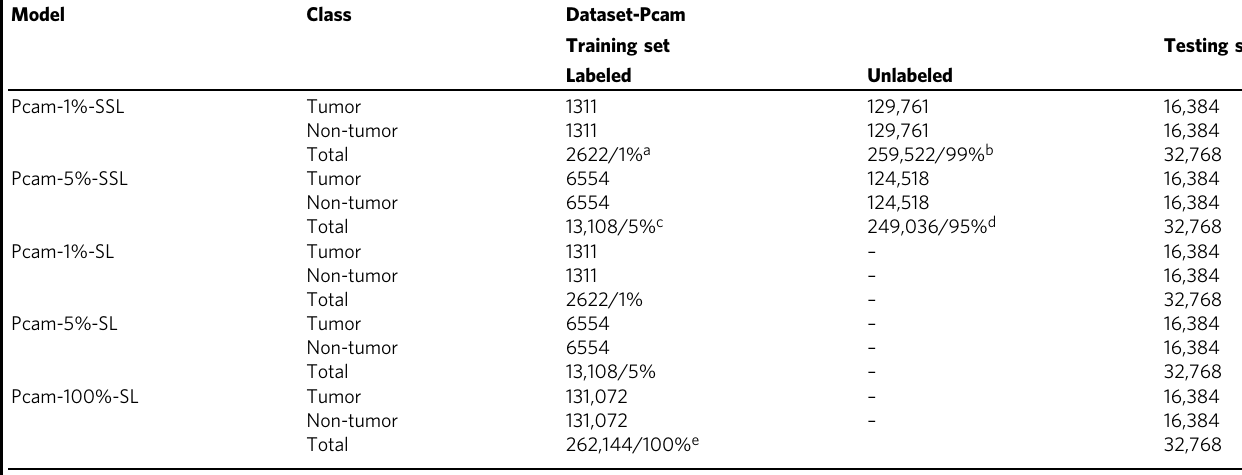
Table 4 Training and testing set for lymph node